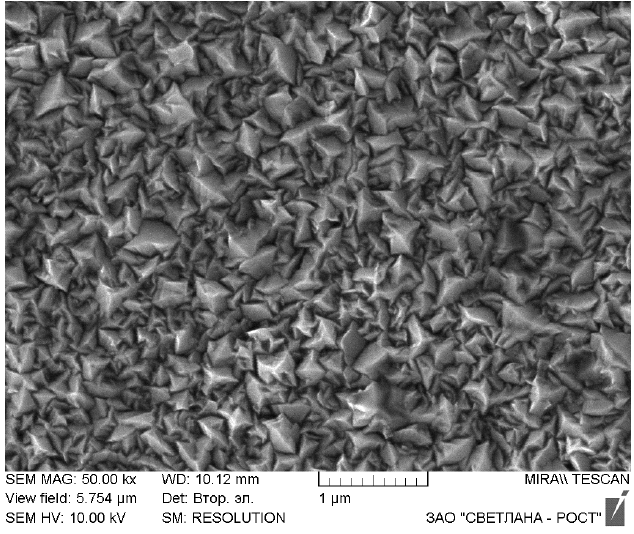
Figure 5. Example of an SEM image of the surface of a zinc oxide test sample.